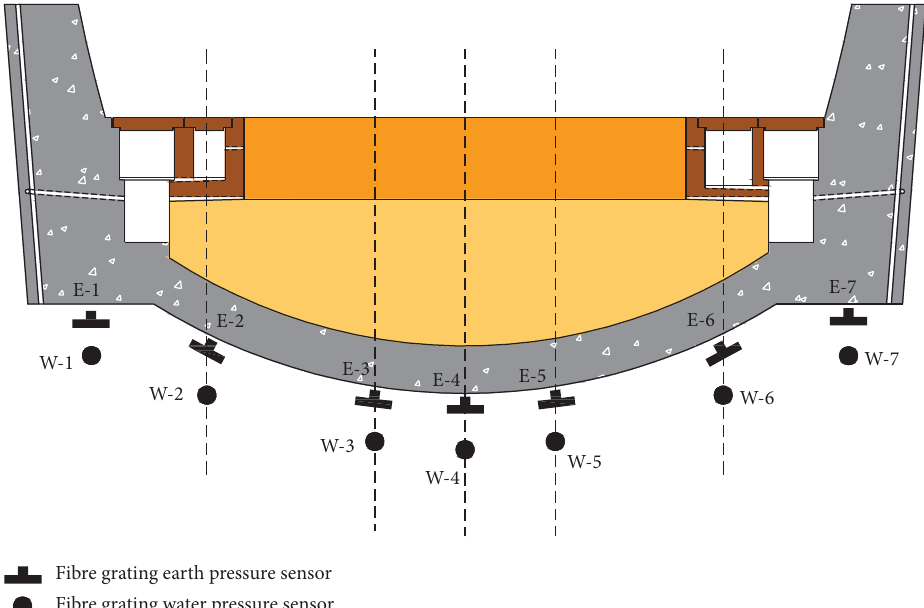
Figure 4: Layout of the basement surrounding rock sensor.